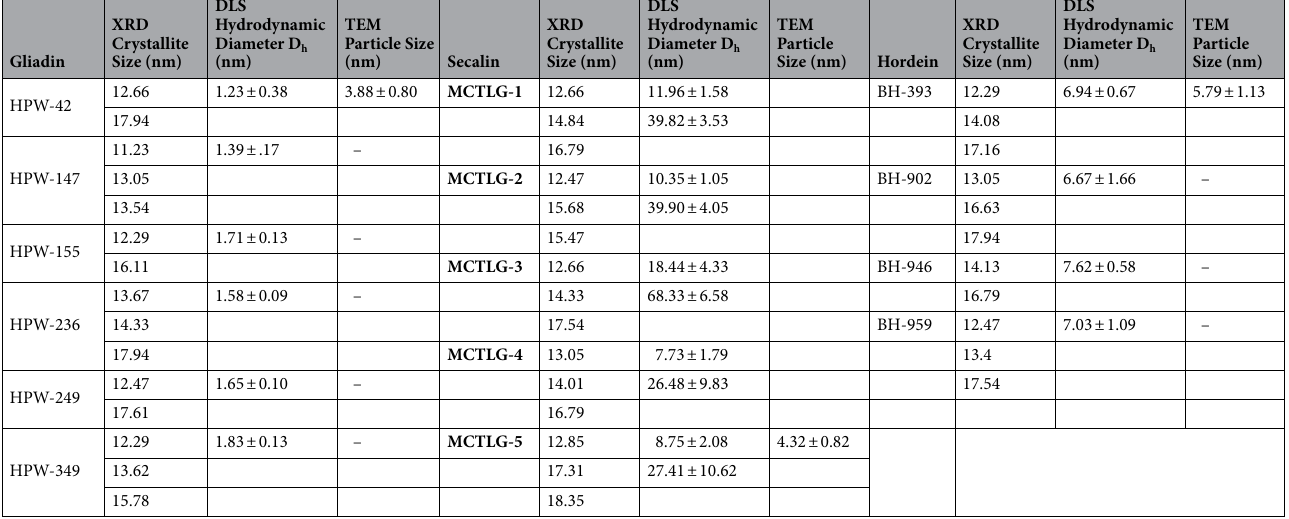
Table 5. The comparative particle size of gliadin, secalin and hordein obtained from XRD, DLS and TEM